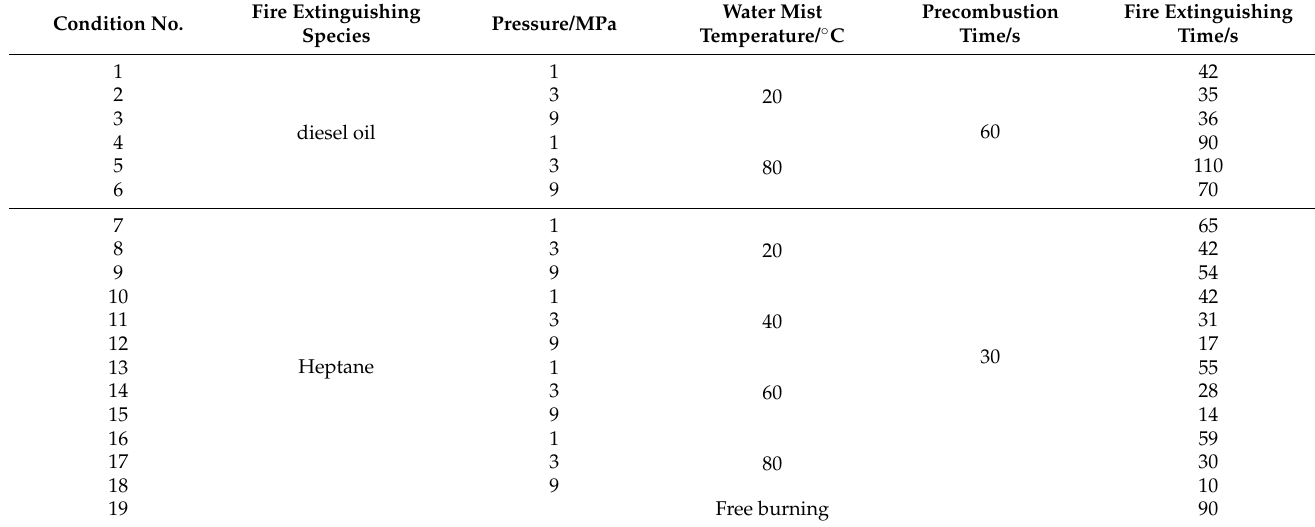
Table 2. Extinguishing time of diesel and n-heptane fires with cold and hot water mist under different